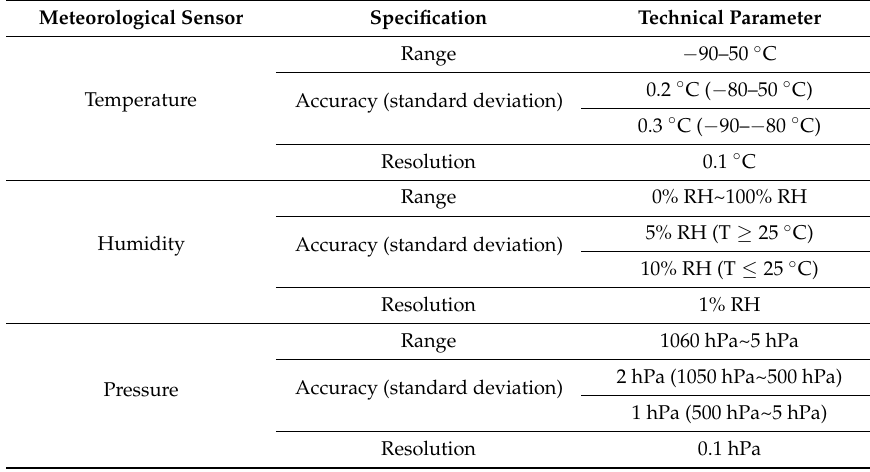
Table 2. Component parameters of the GTS1